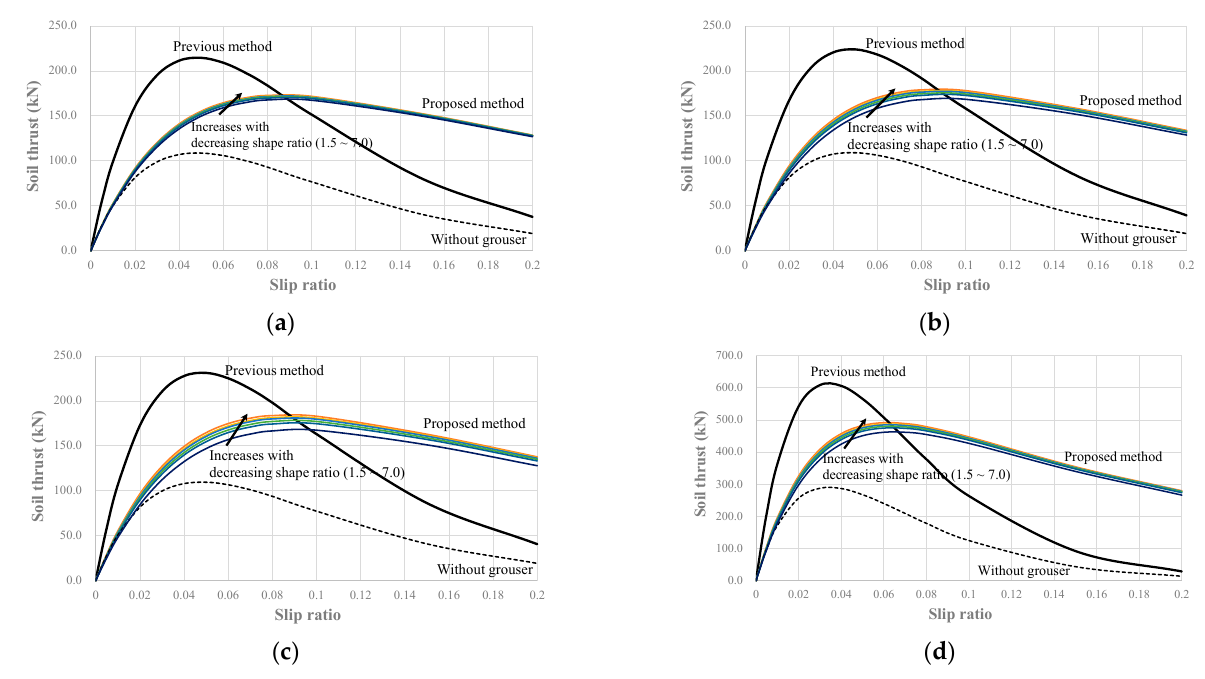
Figure 10. Soil thrust and slip displacement curves in soils exhibiting a hump behavior ( c = 5.9 kPa, 𝜙 = 45.3° , K h = 16.4): EC145E with a grouser height of ( a ) 25 mm ( b ) 50 mm ( c ) 70 mm ( d ) EC380E with 70 mm grouser height.